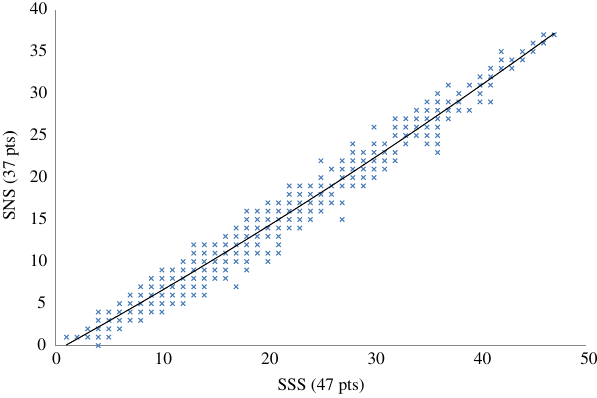
FIG. 1. The correlation between the SSSs and the SNSs of the FMCEJ. The correlation coefficient is r ¼ 0 . 99 ( N ¼ 1095 students). The solid line shows a best fit (regression) to the